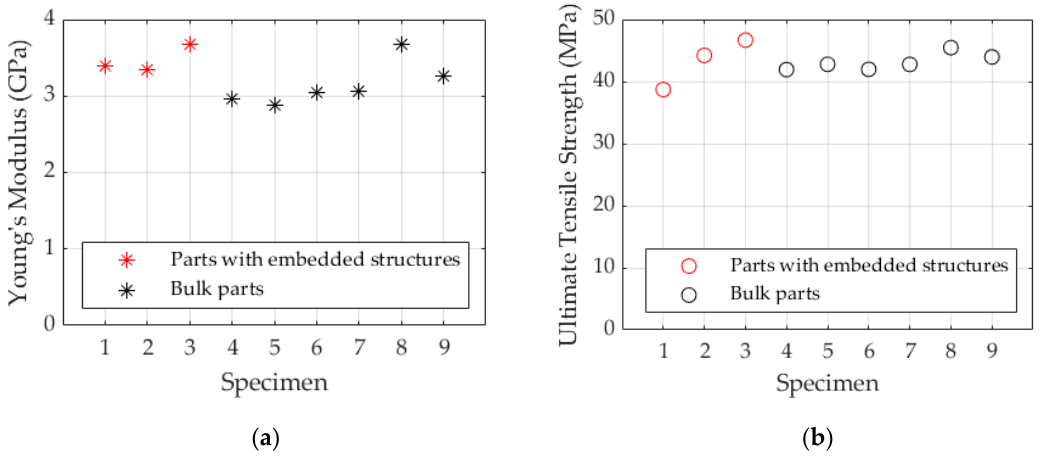
Figure 9. ( a ) Elastic modulus and ( b ) Ultimate Tensile Strength for samples with embedded printed electronics and bulk parts.